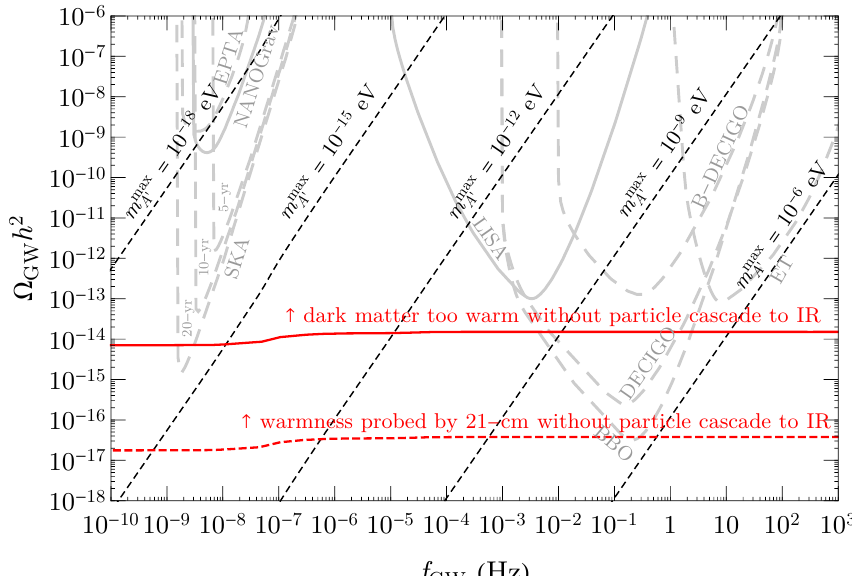
Figure 1 . Correlations between GW signals and dark photon dark matter. In the limit that scatterings subsequent to production are neglected, the region above the red solid curve is excluded in the dark photon dark matter scenario because the produced dark photon would be too warm. Scatterings among dark photons and axions can relax this constraint — see section 4.2. Above the red dashed curve, the warmness can be probed via future 21-cm measurements [67]. The predictions of the dark photon mass are given by the black dashed lines. If scatterings increase the dark photon number, smaller dark photon masses will be predicted, and these contours should be regarded as the maximum possible values m max . The Standard Model g ∗ ( T ) is used, and the quantity r p defined A 0 in eq. (2.12) is fixed at r p = 20 . The warmness constraint and the mass contours change with r p according to eq. (4.1) and eq. (4.3). The sensitivity curves of the gravitational waves are provided by ref. [61] for EPTA [68], NANOGrav [28], SKA [29], LISA [30], (B-)DECIGO [31, 69], BBO [32], and ET